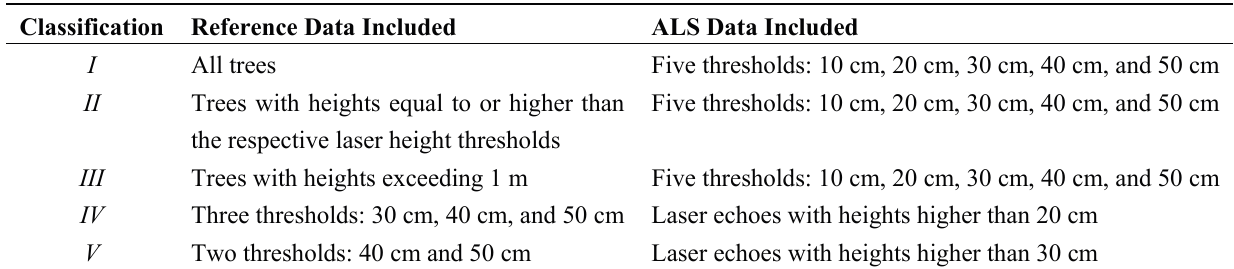
Table 3. Overview of the